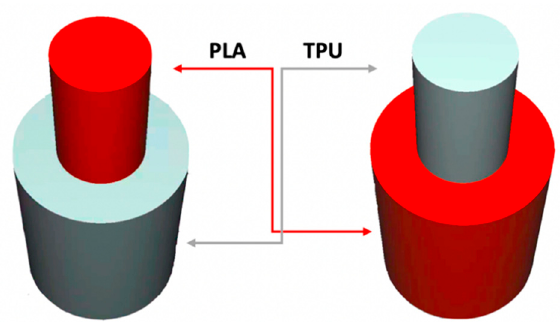
Figure 2. The material printing order for each pattern configuration.